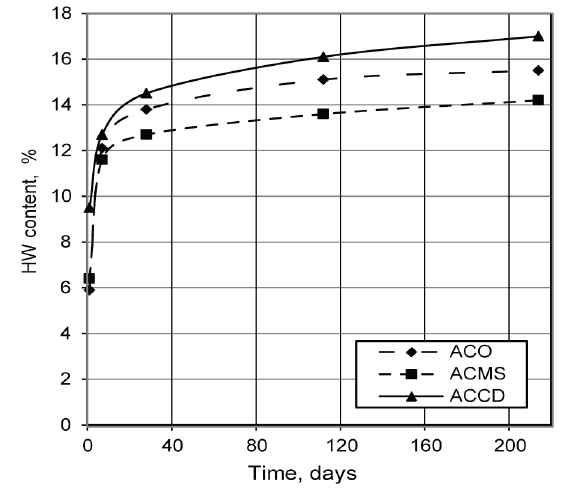
Fig. 3. Variation of hydrated water content in hardening